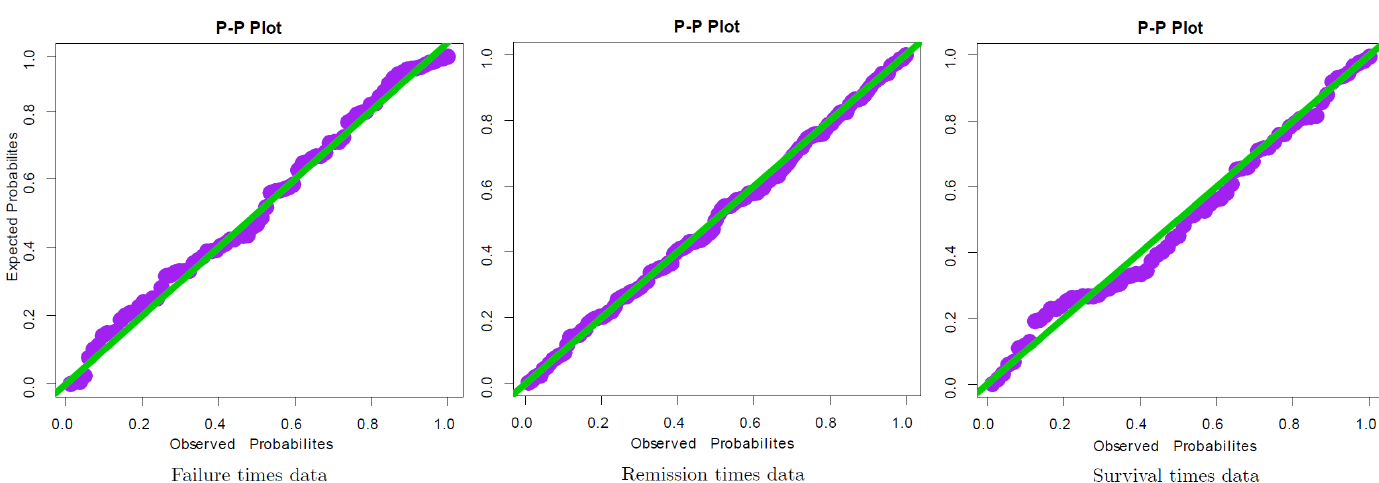
Figure 4: Estimated CDFs.